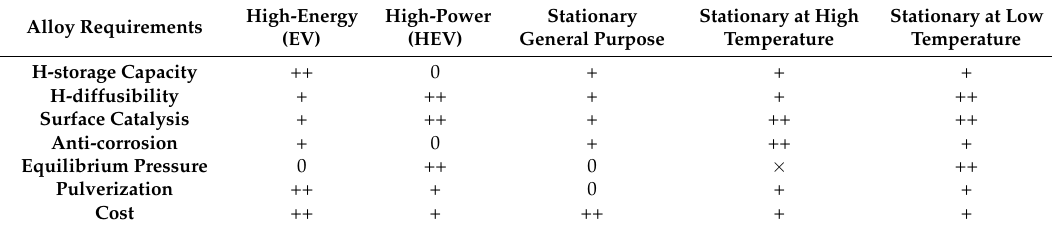
Table 3. Performance requirements of MH alloy in various type of applications. The symbols are ++ (highly desirable), + (important), 0 (not critical), and × (unrelated). EV and HEV represent electric vehicle and hybrid electric vehicle,